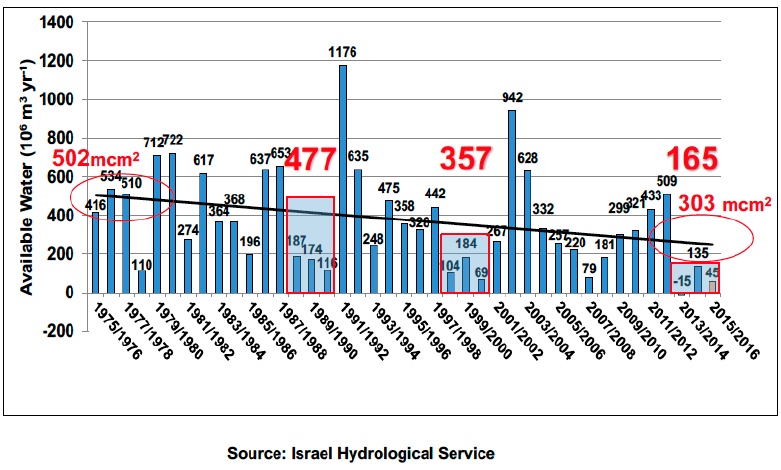
Figure 1. Water availability in Kinneret Lake 1975–2016.